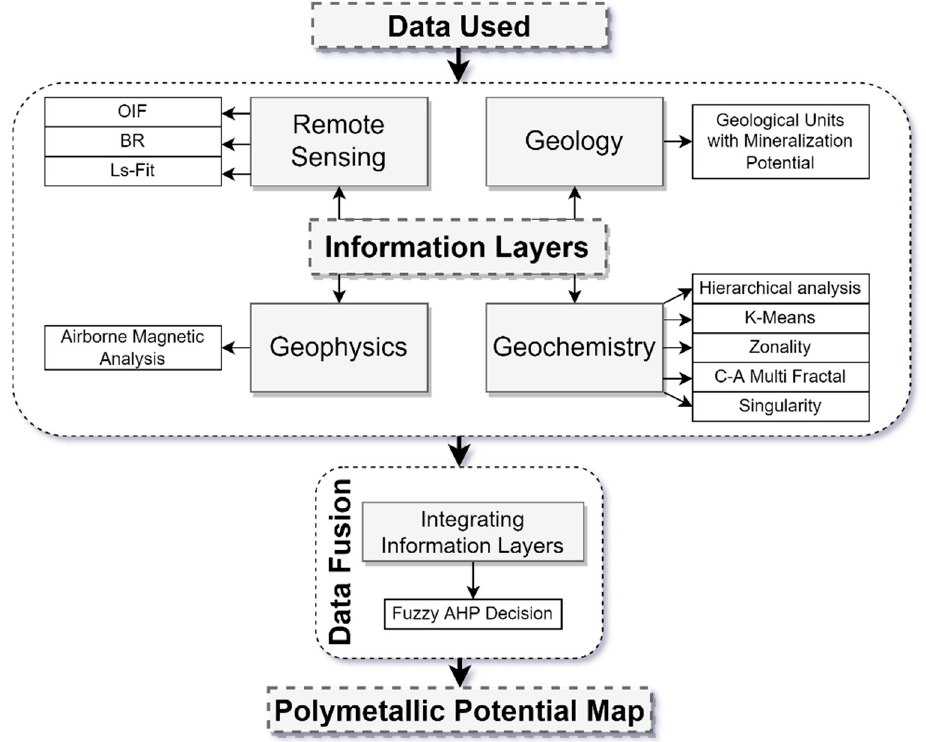
Figure 4. Flowchart of the methodology used in the present study.